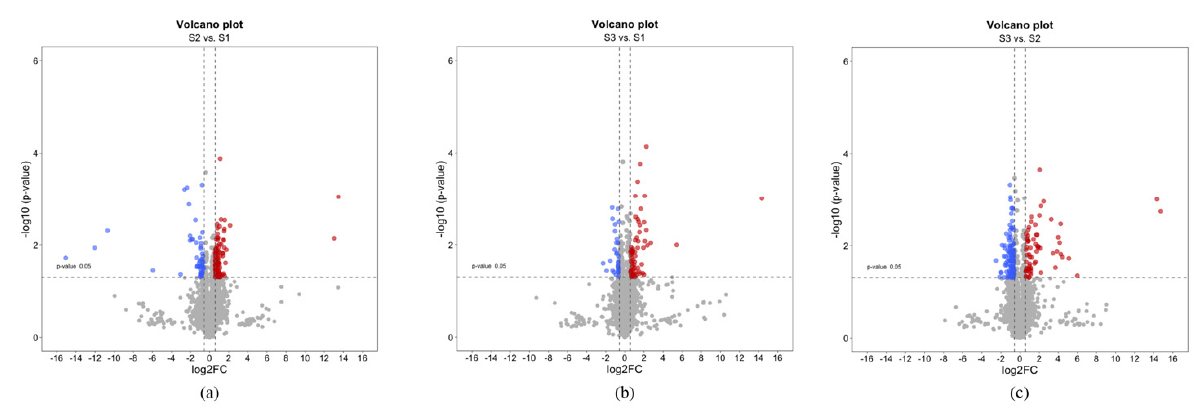
Figure 2. Volcano plot representation of differentially expressed proteins (DEPs) in the three data sets. Statistically significant ( p -value < 0.05), |log2FC| > 0.58) upregulated and downregulated proteins for each data set are indicated with red and blue dots, respectively. Non-significant proteins are represented in gray. ( a ) S2 vs. S1 data set; ( b ) S3 vs. S1 data set; ( c ) S3 vs. S2 data set.